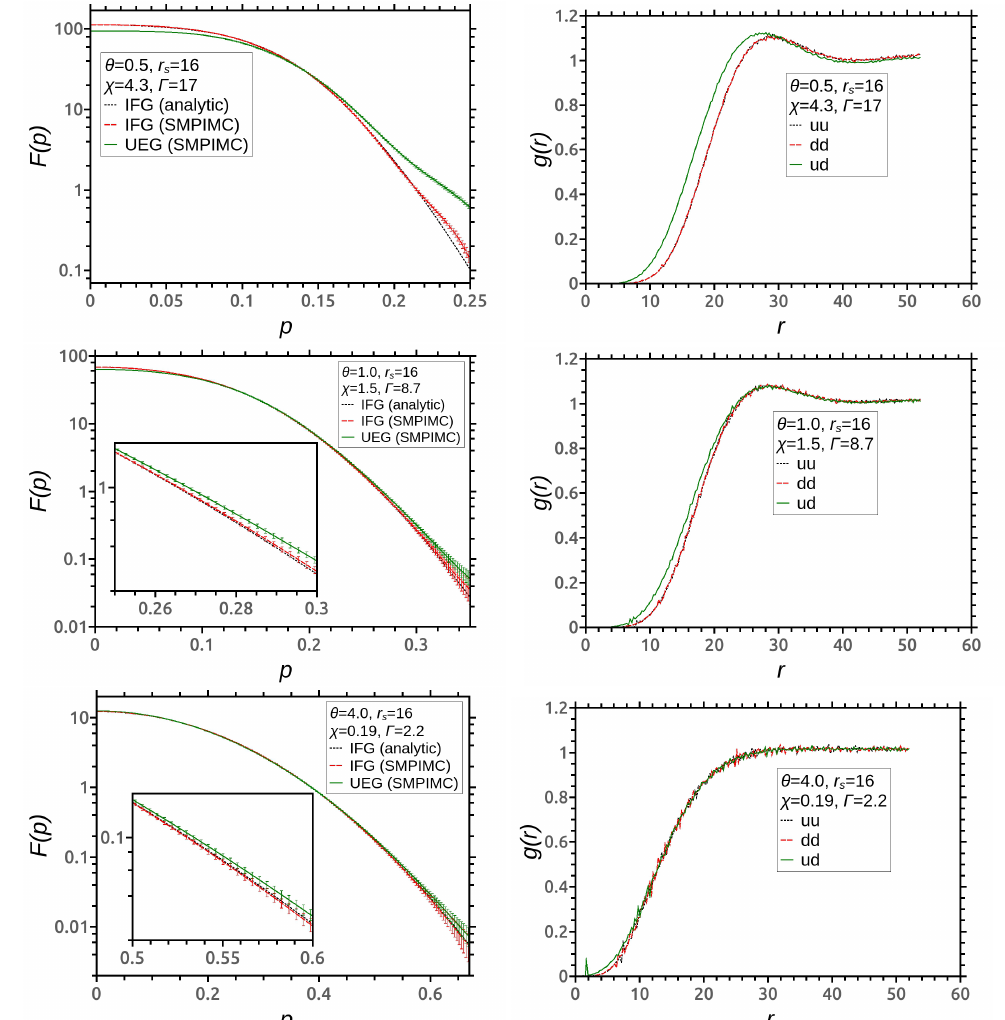
Figure 3. Left plots: single-particle MDFs of the unpolarized UEG at r s = 16 and θ = 0.5,1,4 calculated with the SMPIMC method. The results are compared with the SMPIMC for the IFG at the same conditions, and with the analytical Fermi distributions. Right plots: PCFs g uu , g dd , and g ud of the